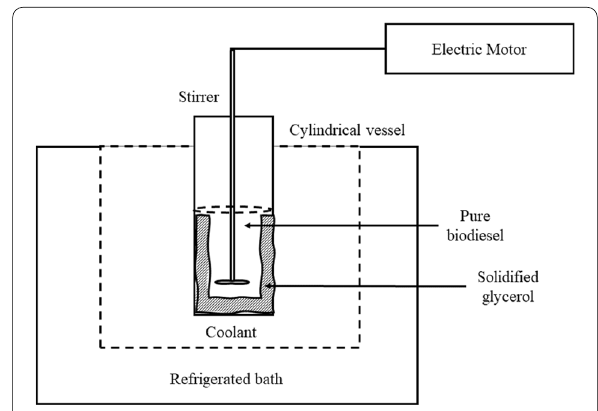
Fig. 1 Transesterification reactor setup for biodiesel production Fig. 2 SAC system